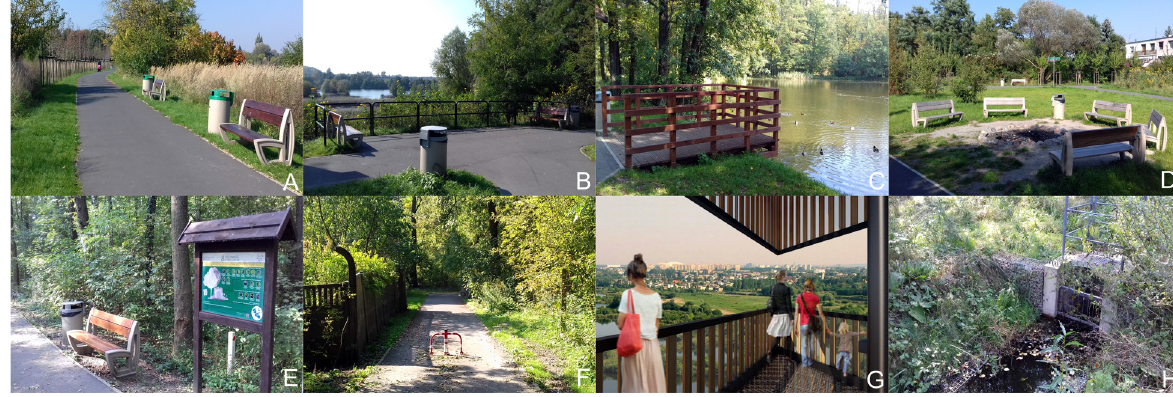
Fig. 2. The examples of the investments made in the Szachty